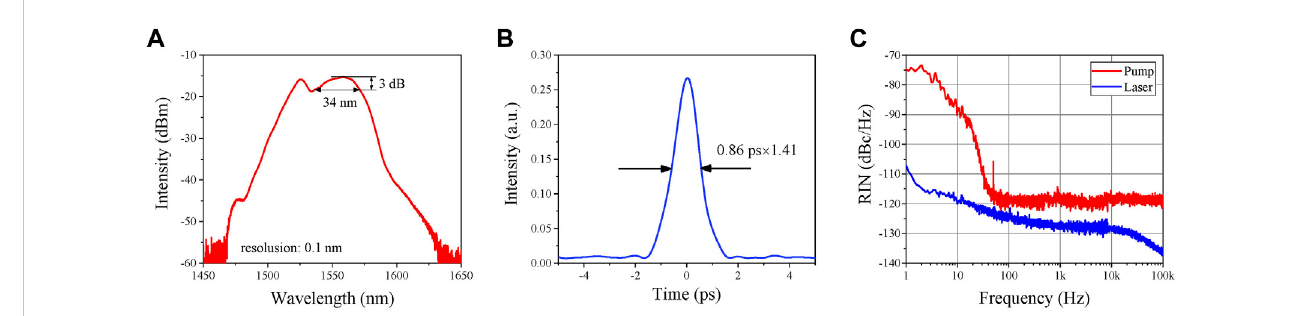
FIGURE 2 Spectrum (A) , autocorrelation curve (B) , and relative intensity noise (C) of the oscillator.